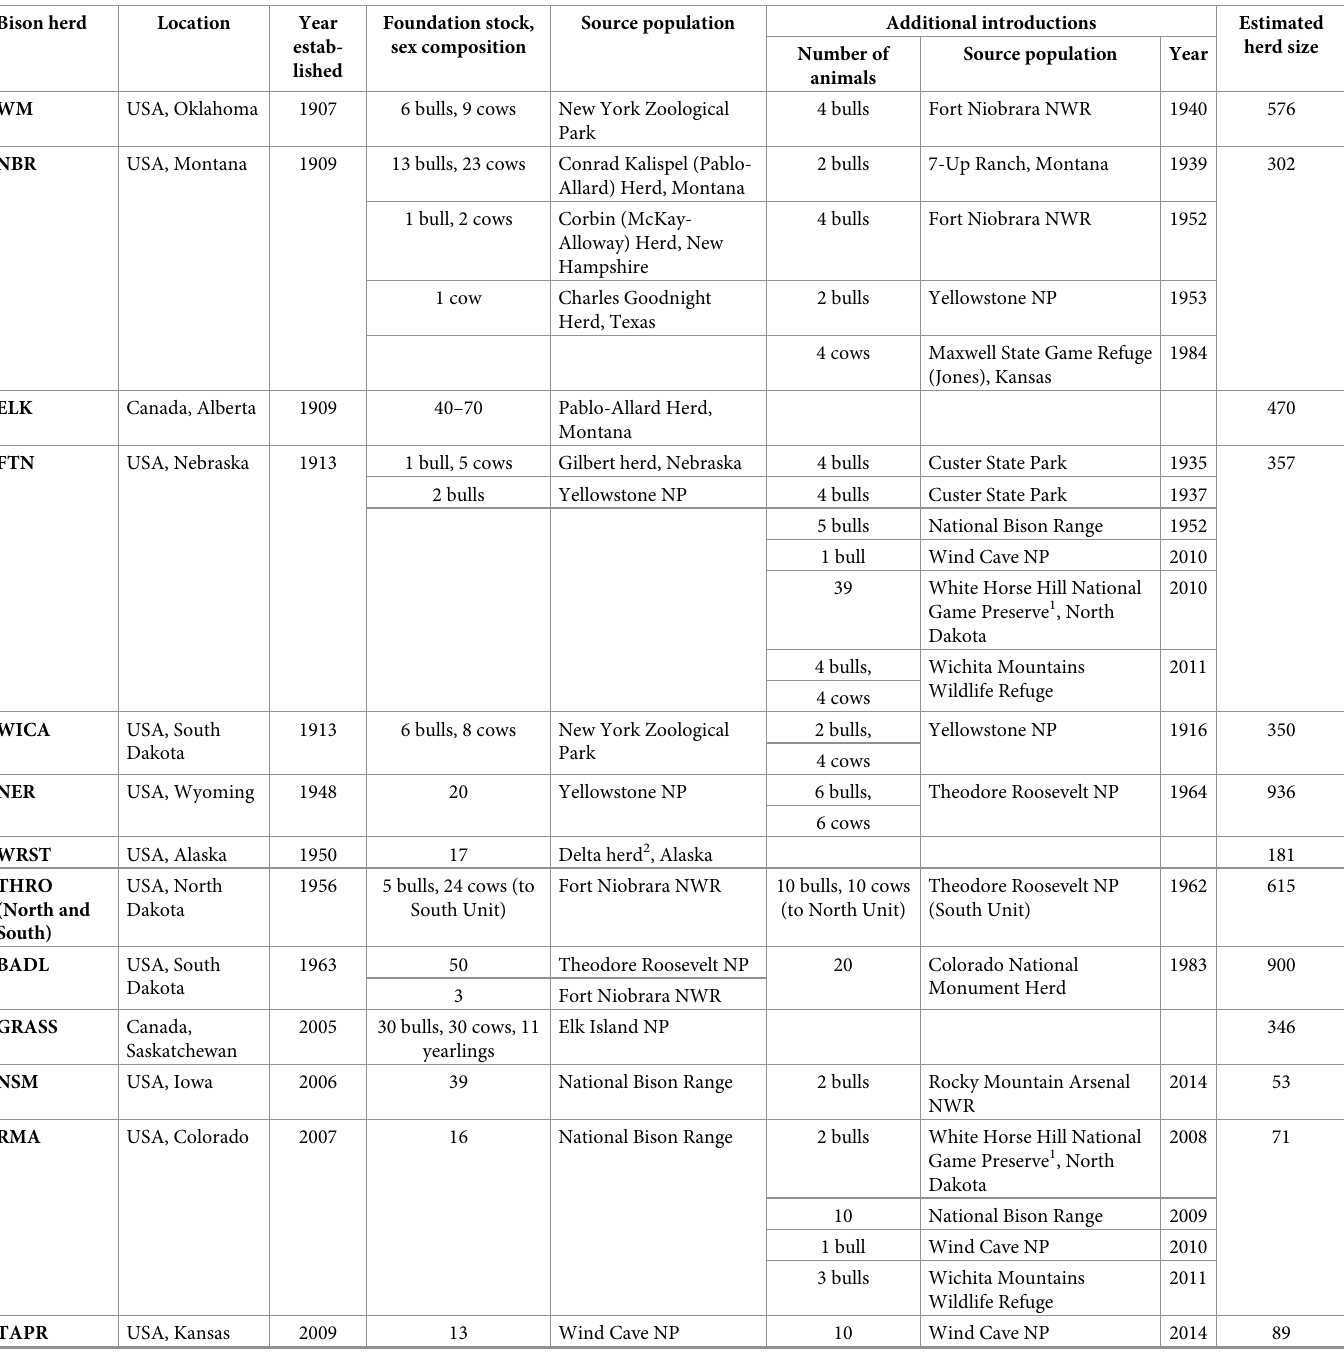
Table 3. Establishment of bison herds. Origin, founding members, additional introductions, and estimated size at sampling of 14 U.S. Department of Interior and Parks Canada Agency bison herds. Founding and translocation data from Coder, 1975 [24], Halbert and Derr, 2008 [21], Boyd, 2003 [23], Dratch and Gogan, 2010 [8], and Hart- way et al., 2020